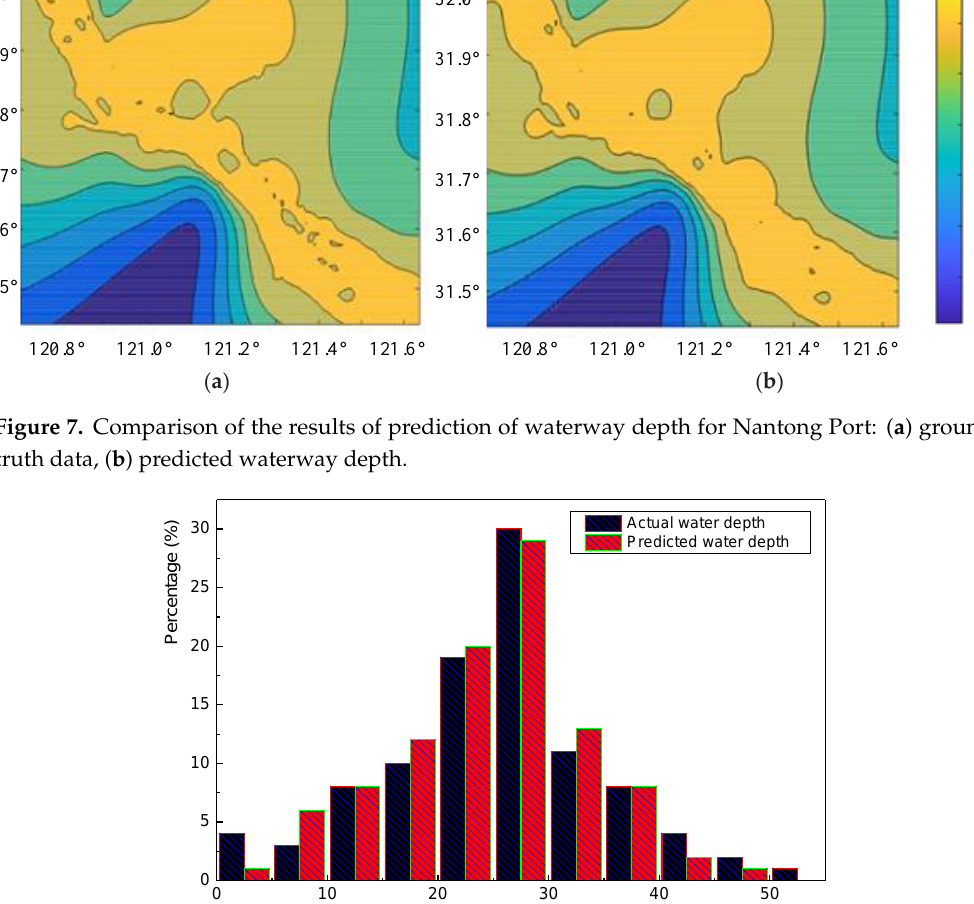
( b ) Figure 9. Comparison of the results of prediction of waterway depth for Fangcheng Port: ( a ) ground truth data, ( b ) predicted waterway depth.